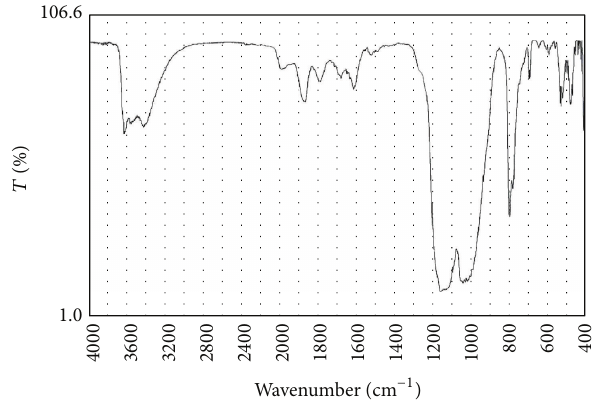
Figure 1: Infrared spectrophotometry revealed that the calculus was comprised of over 98% of silicon